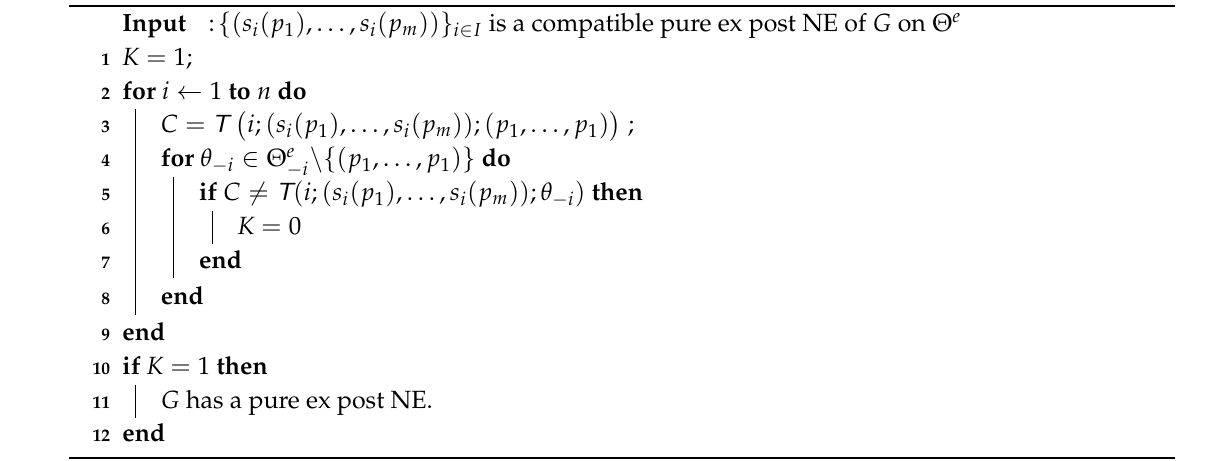
Algorithm 1: The test for the existence of a pure ex post NE